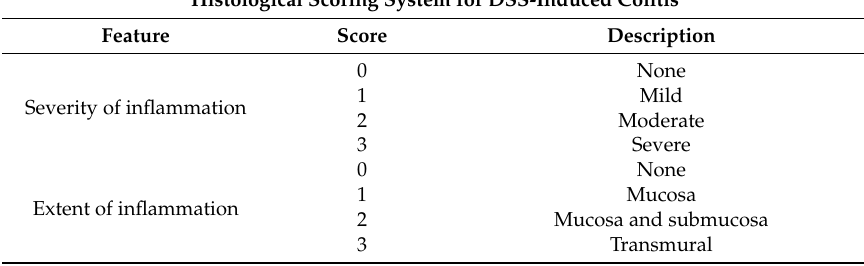
Table 2. Scoring system used to calculate the histological score in dextran sulphate sodium (DSS)-induced